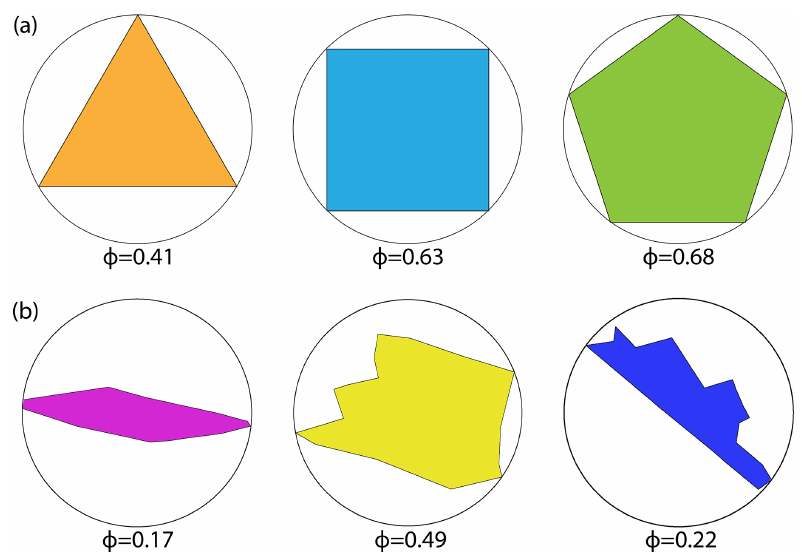
Figure 10. (a) Shape factors for regular block shapes with equal edge lengths and (b) shape factors for polygonal blocks resulting from real fracture networks in Region 1 (dimensions are